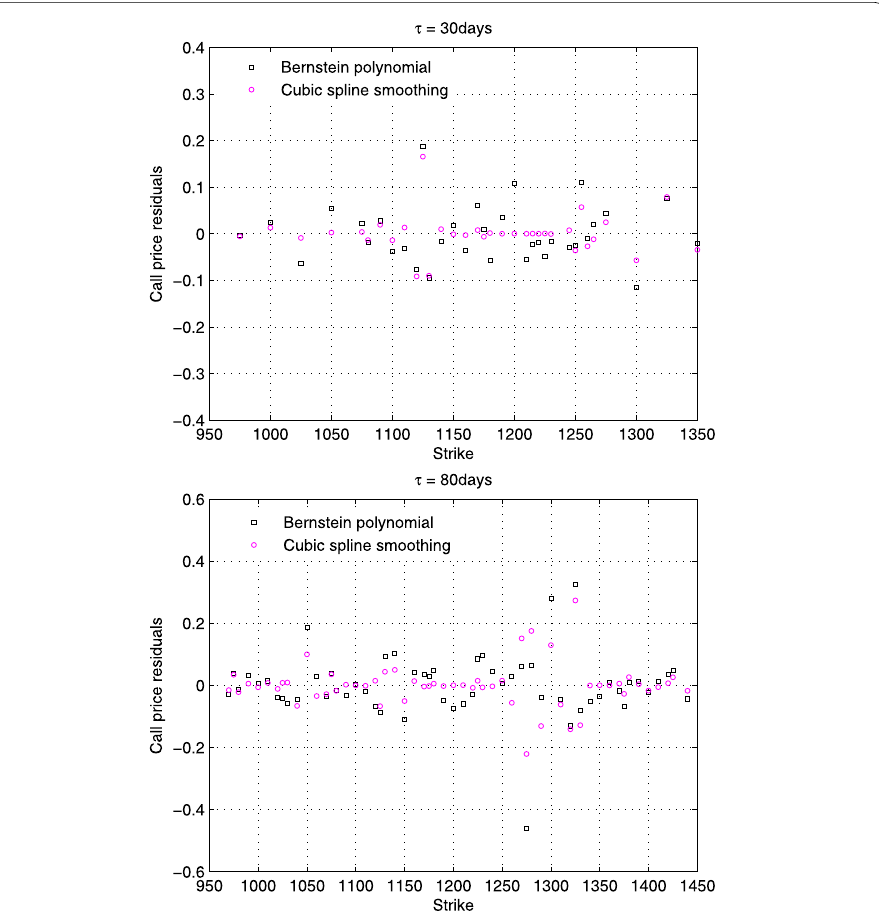
Figure 3 Call price residuals are computed as C i – ˆ C i , where C i is the mid price of the observed bid and ask quotes and ˆ C i denotes the value of the arbitrage-free estimated price. Results are reported for both of the times to maturity of τ = 30 days and τ = 80 days,